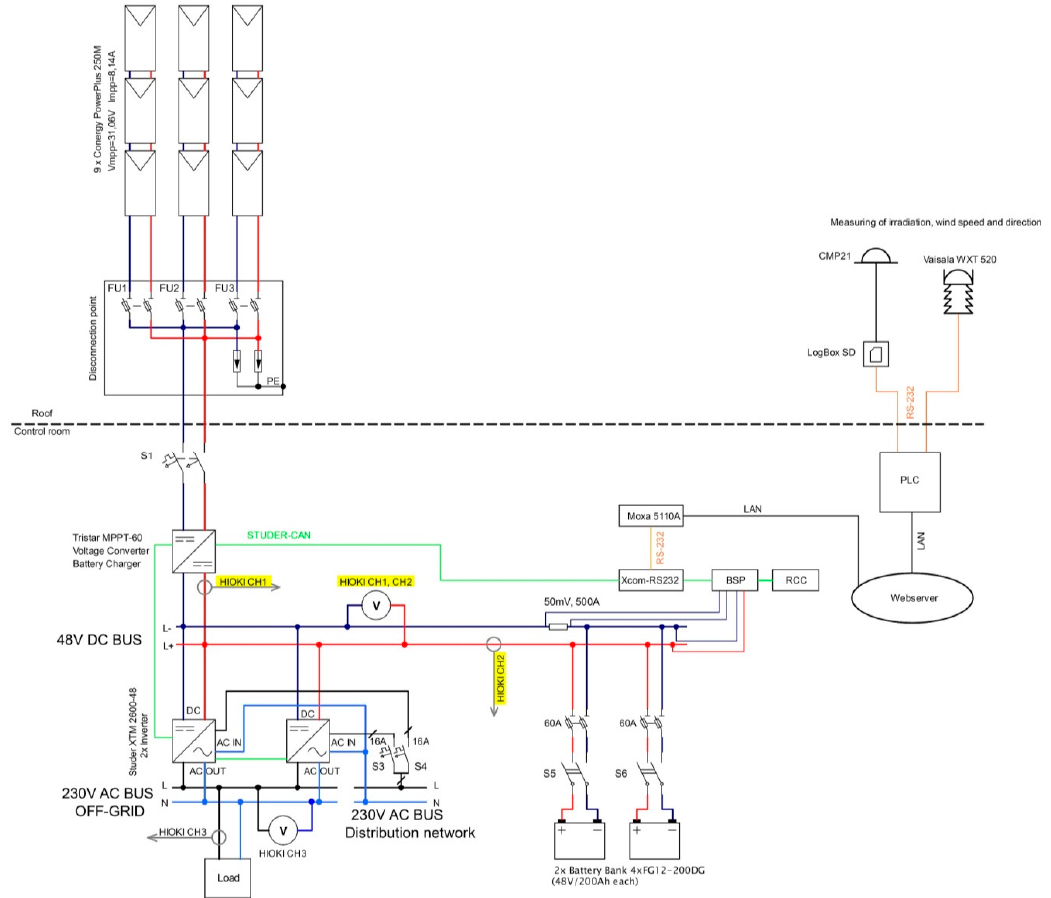
Figure 11. Schematic of experimental HS, with measuring points marked.